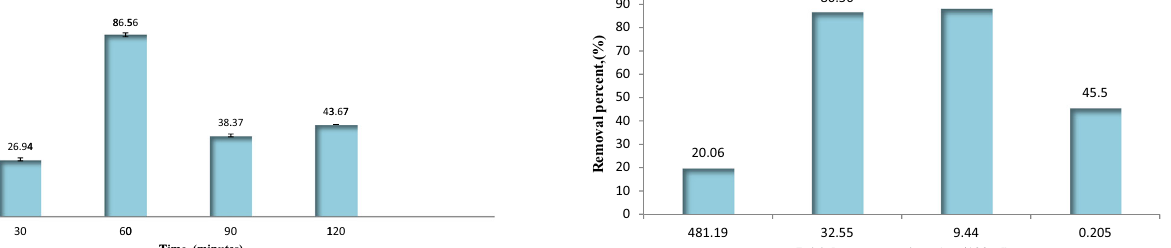
Fig. 2 Effect of contact time on the removal percent of iron III when the initial concentration was (10 − 2 M), at solution pH 2.4, and using 4 g/100 ml of A. niger as bioadsorbent at room temperature. n = 3 determinations.